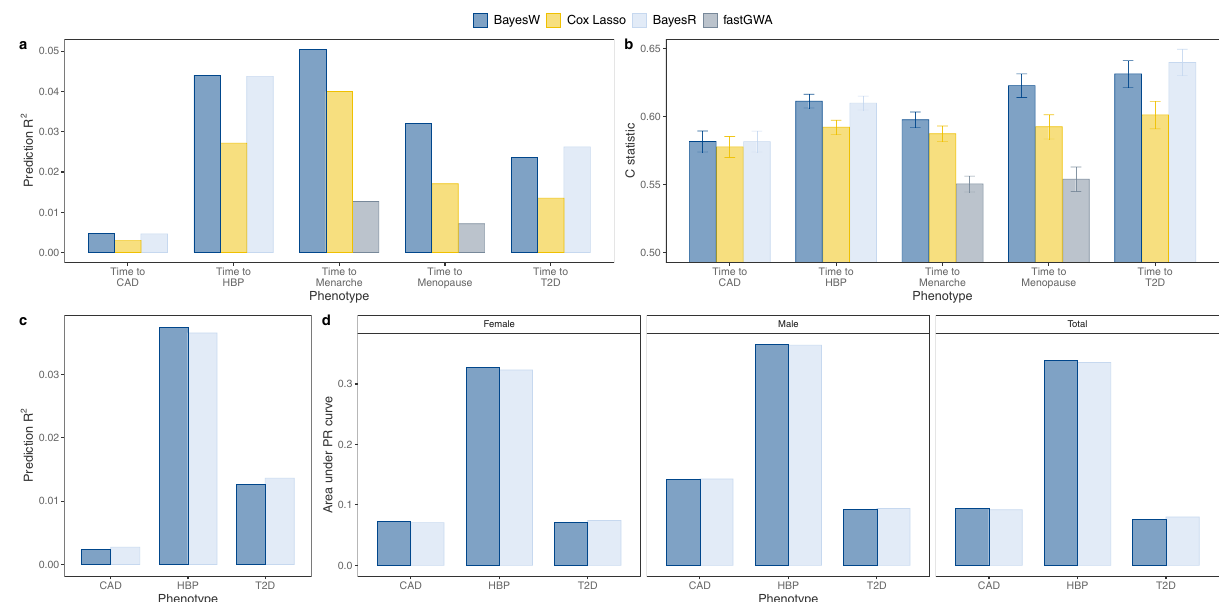
Fig. 4 Prediction into the Estonian biobank. BayesW and Cox-LASSO (estimated with snpnet) methods were used for all of the phenotypes; BayesR was used to see how case-control model predicts time-to-diagnosis phenotypes (CAD, HBP, T2D); fastGWA was used to see how marginal model performs when predicting continuous traits. BayesW and Cox-LASSO models were estimated using sample sizes of N = 360,715; 371,878; 372,280; 200,493 and 151,472 for time-to-diagnosis of CAD, HBP, T2D and age-at-menarche and age-at-menopause, respectively. The number of validation individuals from the Estonian Biobank was N = 32,594 for the time-to-diagnosis traits and N = 18,134 and 19,368 for age-at-menarche and age-at-menopause, respectively. a Prediction R 2 when predicting Estonian martingale residuals of time-to-event phenotypes using either BayesW, Cox-LASSO, BayesR or fastGWA model trained on the UK biobank data, martingale residuals were calculated from Cox PH model with an intercept and sex if applicable; ( b ) Harrell ’ s C-statistic, calculated from Cox PH model where true phenotype was regressed on the genomic prediction and gender data (for CAD, HBP and T2D). Height of the bars represents the C-statistic and error bars represent corresponding 95% con fi dence intervals; ( c ) Prediction R 2 when predicting Estonian binary phenotypes (CAD, HBP, T2D) using either a model based on time-to-event data (BayesW) or case-control data (BayesR), the binary phenotypes that were used for the comparison were adjusted for age and sex; ( d ) Area under Precision-recall curve when predicting Estonian binary phenotypes (CAD, HBP, T2D) using either BayesW or BayesR, areas under the curve were calculated separately for females, males and everyone